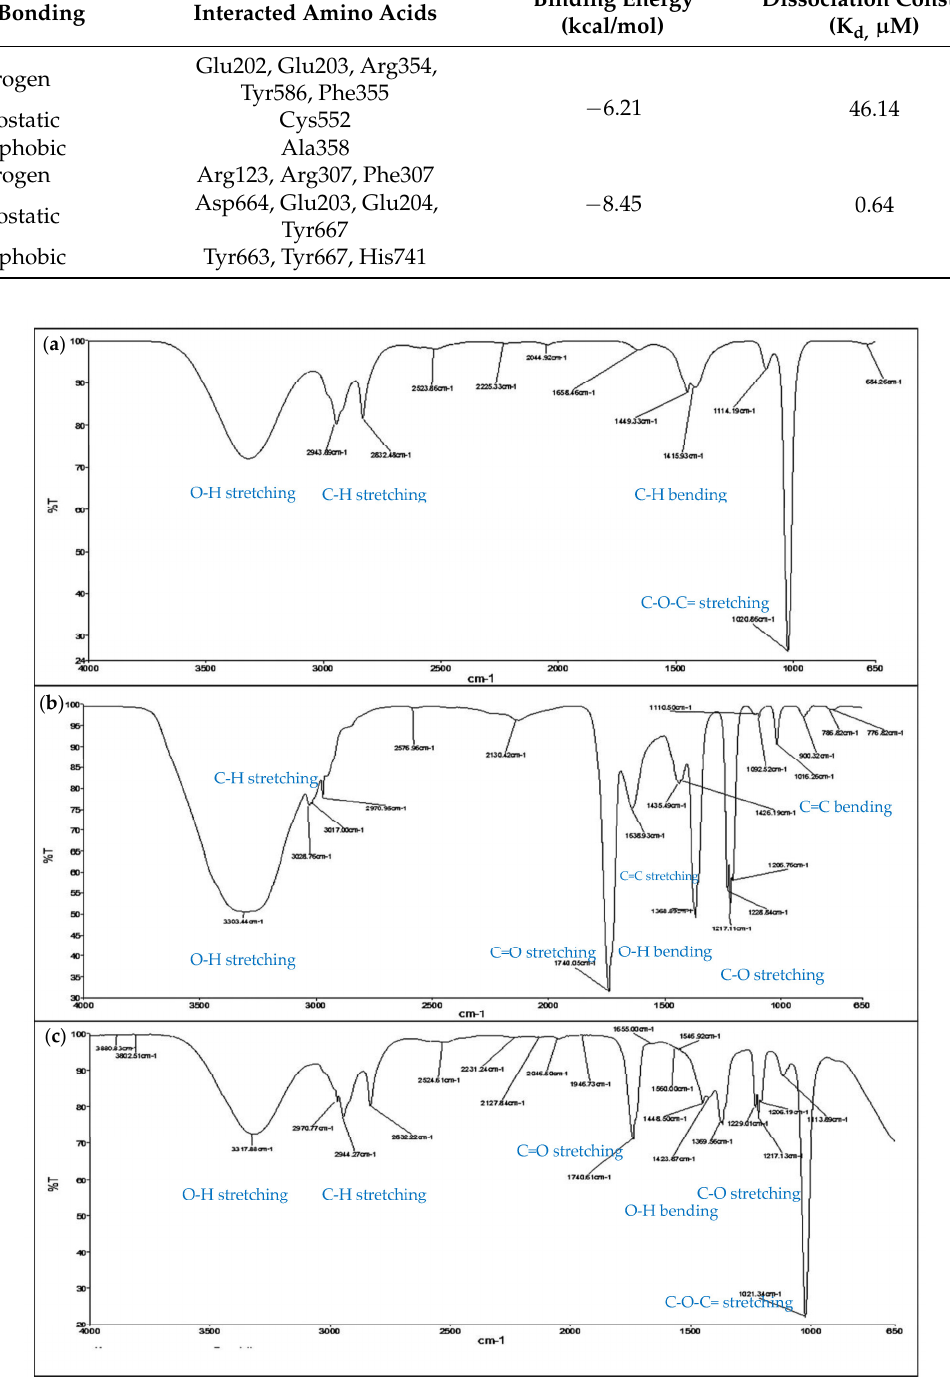
Figure 6. Identification of the functional groups of quercetrin detected in samples after extraction and fractionation using Fourier transform infrared spectroscopy (FTIR). The detection of functional groups is indicated in the FTIR spectra of ( a ) quercetrin-rich fraction, ( b ) crude extract, and ( c ) standard quercetrin for comparison.